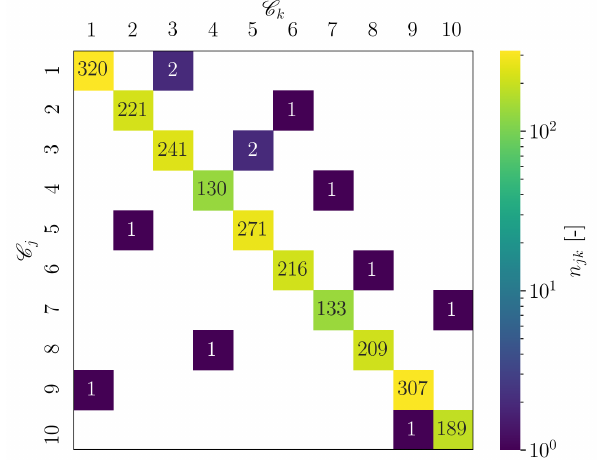
Figure 25. Counted cluster transitions for setup 2 of the wind turbine